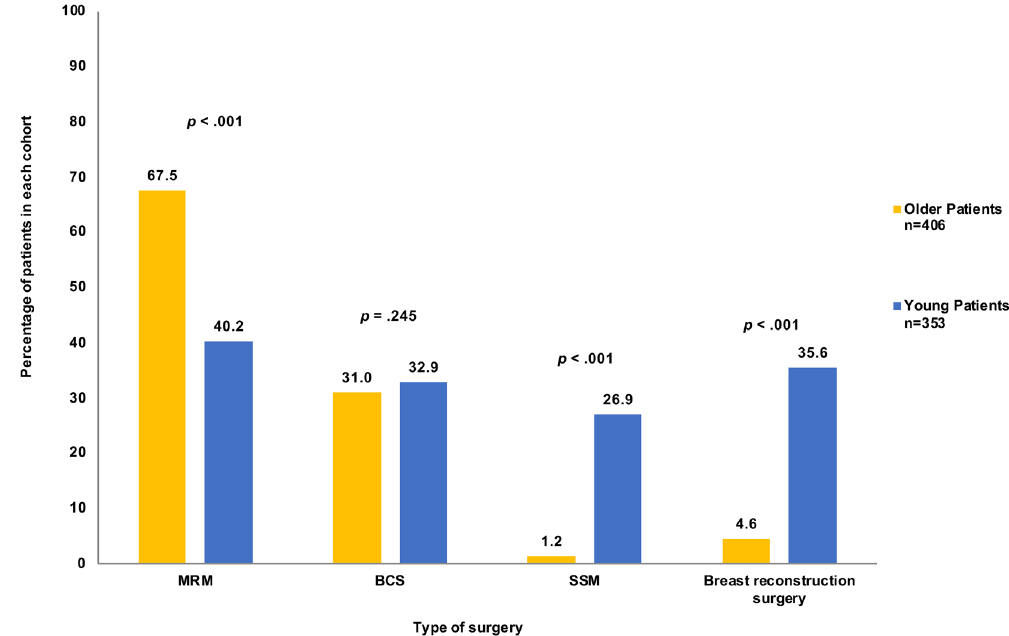
Figure 2. Difference in surgical management in patients with nonmetastatic (M0) disease. MRM = modified radical mastectomy, BCS = breast conserving surgery SSM = skin-sparing and/or nipple-sparing mastectomy.